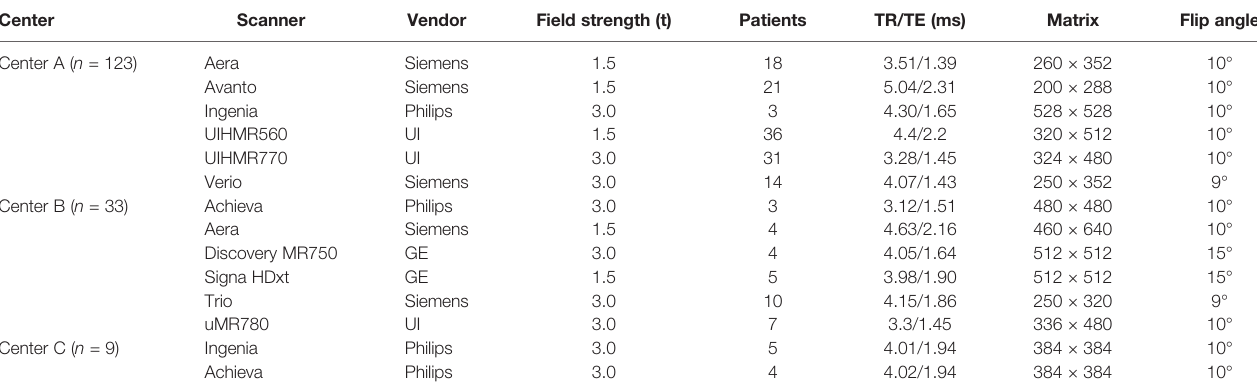
TABLE 1 | Detailed parameters of contrast-enhanced three-dimensional fs T1W gradient-echo sequences in each center.